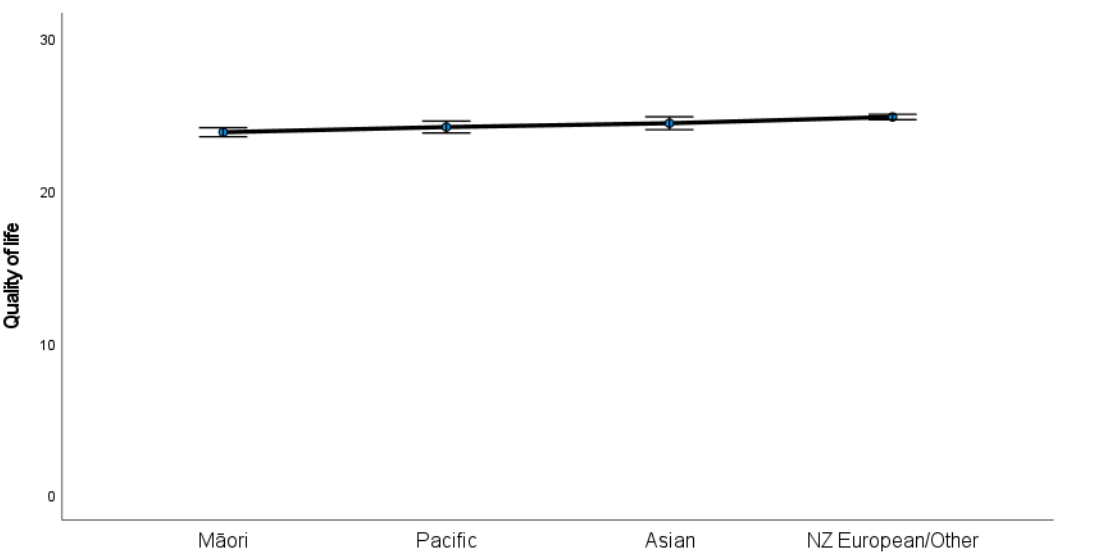
Figure 1. Mean and 90% confidence interval of gambling risk, social connectedness, leisure activities, psychological distress, and quality of life among groups.